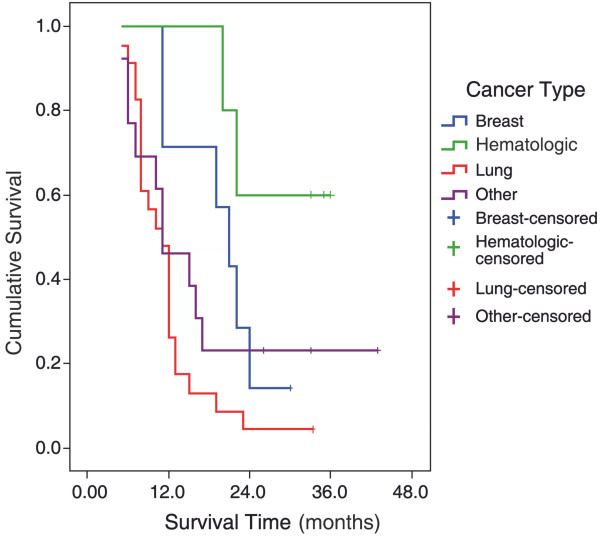
Survival for patients with cancer by tumor type.